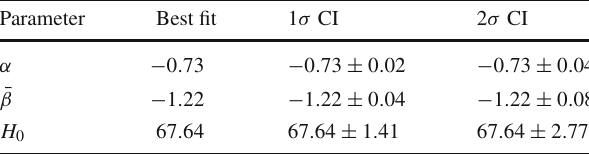
Table 1 The best-fit values of the parameters α , ¯ β , and H 0 for the conformally invariant quadratic Weyl geometric model (91) Parameter